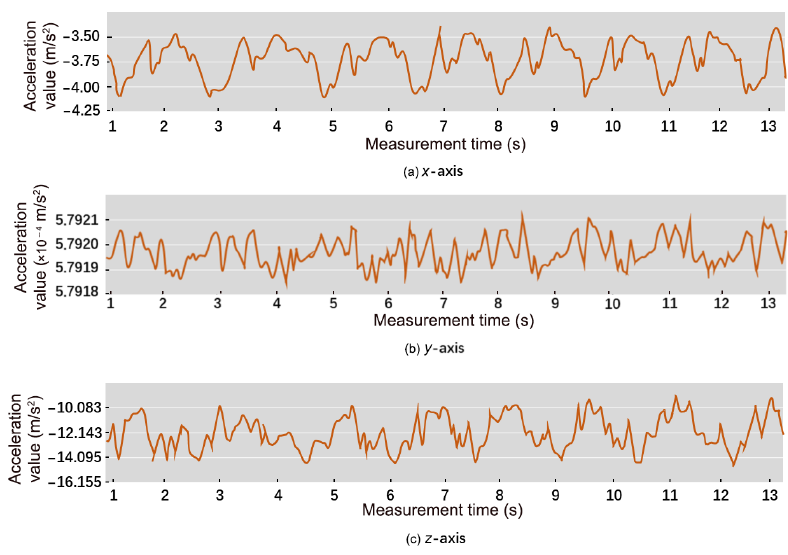
Fig. 1 Line chart of individual gait information